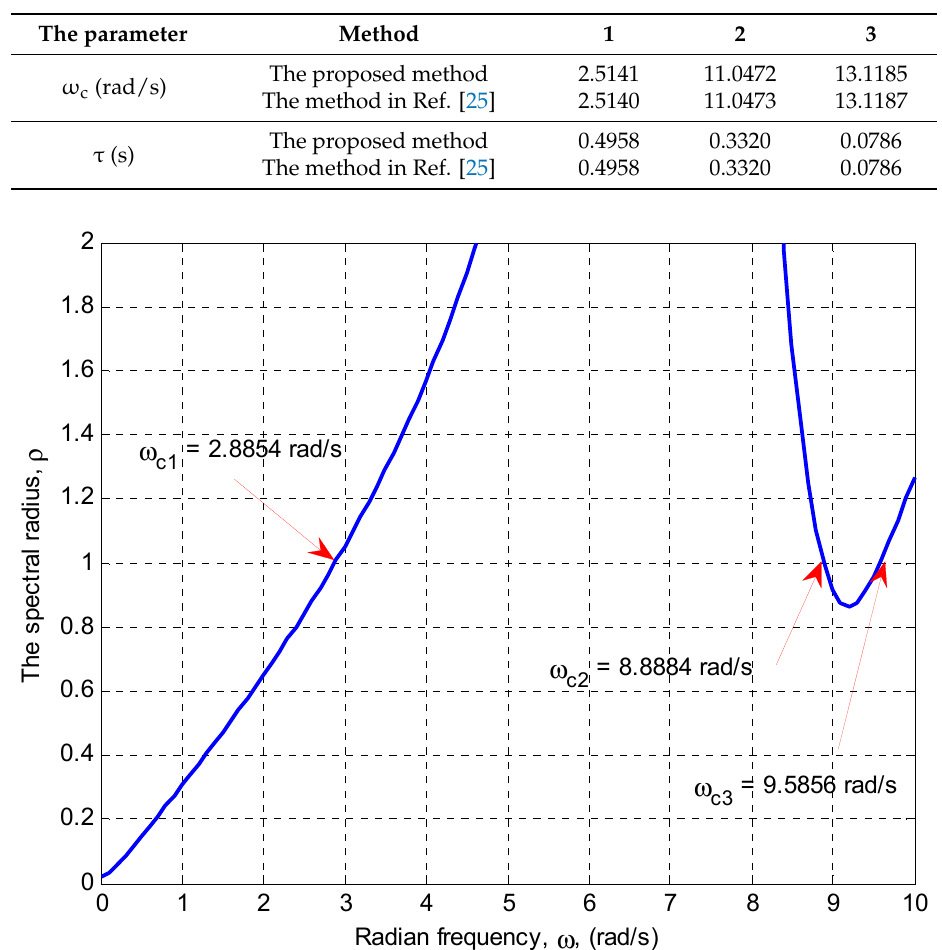
Figure 7. The spectral radius as function of ω .